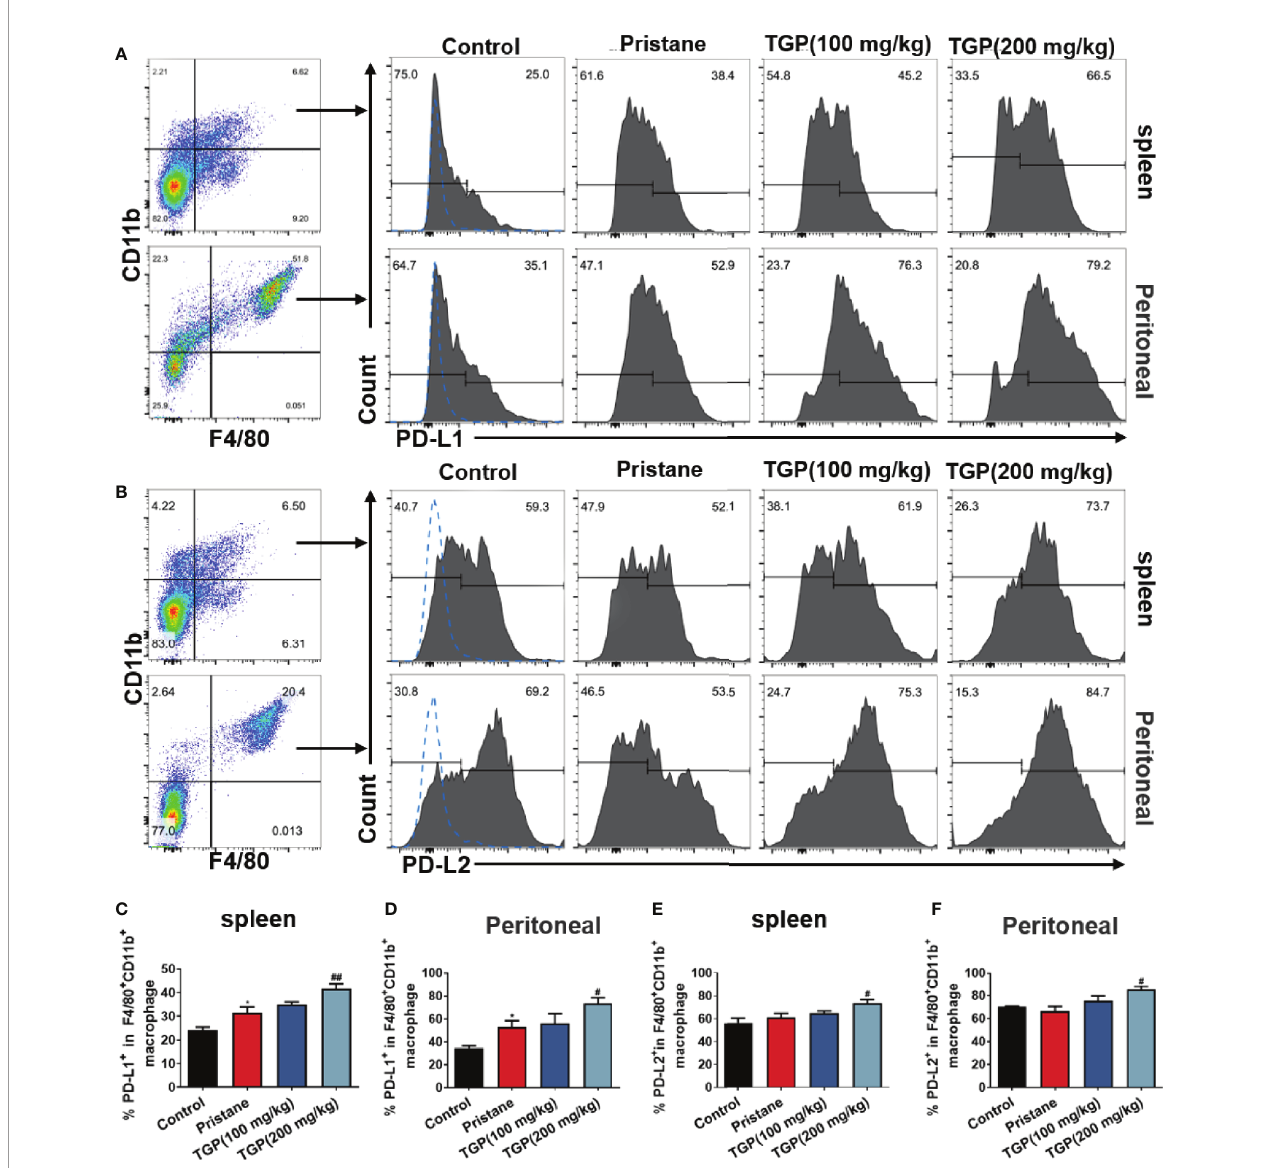
FIGURE 3 | TGP treatment upregulates macrophage expression of PD-Ls in pristane-induced lupus mice. Single-cell suspensions from spleens and peritoneal lavage fl uids were collected 8 weeks after TGP treatment following pristane injection 24 weeks ago. The effects of TGP on the frequency of PD-L1 + (A) or PD-L2 + (B) subsets in splenic and peritoneal F4/80 + CD11b + macrophages were determined via FACS. (C, D) The percentages of PD-L1 + subset in splenic and peritoneal F4/80 + CD11b + macrophages are shown as means ± SD. (E, F) Shown are the means ± SD of the percentages of PD-L2 + subset in splenic and peritoneal F4/ 80 + CD11b + macrophages. (n=5-6, *p < 0.05 compared with control, and ## p < 0.01 or # p < 0.05 compared with pristane treated